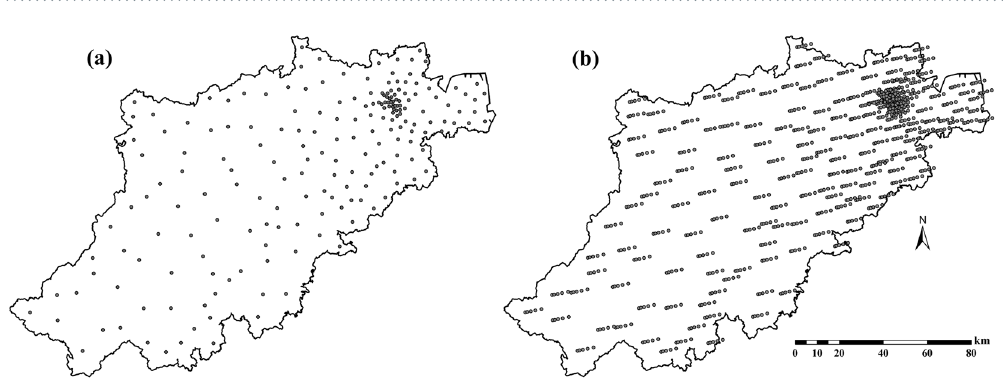
Figure 4. Empirical covariance (red circles) and theoretical covariance model (continuous line) of the original space-time BC incidence distribution in R 2 × T .